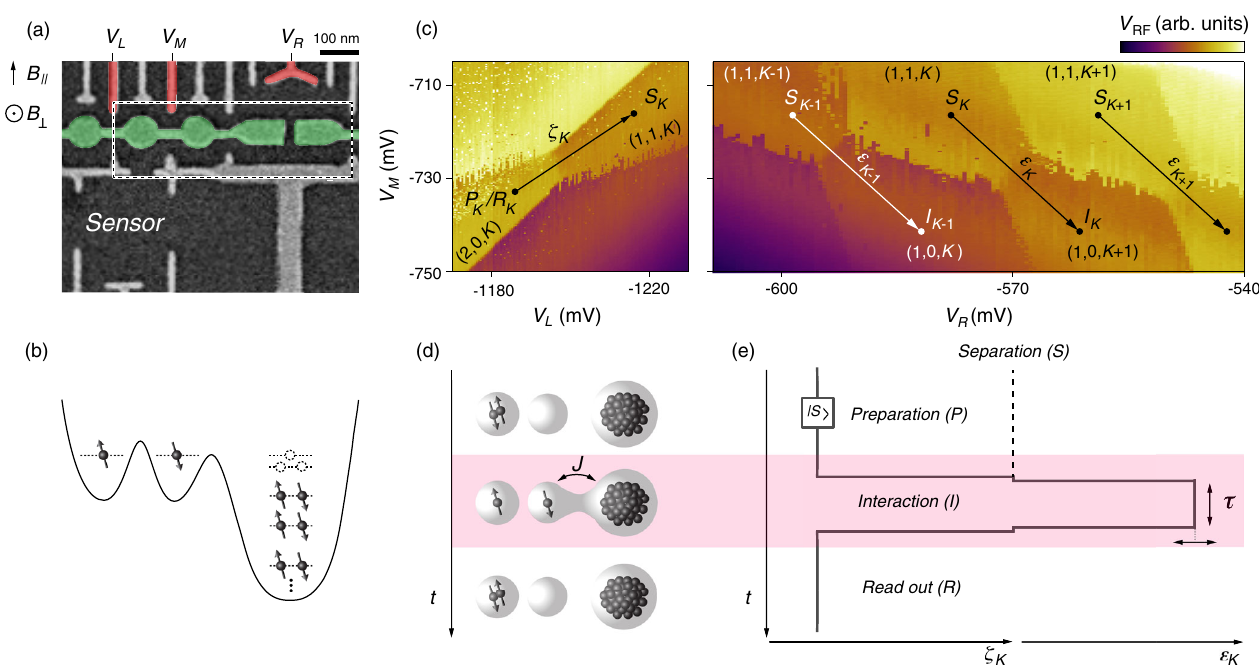
FIG. 1. (a) Scanning-electron micrograph of the device, colored in gray and red to indicate metallic gate electrodes that deplete the 2DEG below the surface (negative voltages). Accumulation gates (colored in green, positive voltages) steepen the resulting confining potential of the quantum dots that form underneath. Voltage pulses applied to the gates V control individual electrons in the triple- L;M;R dot array on a nanosecond time scale. (b) Illustration of the electron configuration in the resulting triple quantum dot. We refer to the left and middle dot as the double dot, and to the right dot as the multielectron dot. The precise single-particle level structure and occupation number of the right dot determine the spin properties of the multielectron dot, and are the focus of this experiment. (c) Charge diagrams of the triple quantum dot in the absence of voltage pulses. The left-hand panel shows the interdot charge transition of the two-electron double quantum dot. The right-hand panel presents the charge transition at which the middle electron transfers to the multielectron quantum dot, for different initial occupations of the multielectron dot ( K − 1 , K , and K þ 1 ) depending on V . Labels P , R , and S R K K K indicate positions in gate-voltage space at which the electron pair is, respectively, prepared, read out, and separated, if appropriate time- dependent voltage pulses are applied. In particular, arrows labeled ζ and ε indicate axes in gate-voltage space used to define the K K voltage pulses in this experiment. For example, gate voltages associated with the interaction step ( I ) are varied systematically (see K Sec. II), but always remain on the ζ or ε axis. (d) Operating principle of probing the multielectron spin state by the two-electron K K double dot. First, a pair of electrons is prepared in a singlet state on the left dot. Next, one of these electrons is transferred to the middle dot, allowing a spin-sensitive interaction ( J ) with the multielectron dot. In the last step, the spin of the middle electron is measured relative to the reference electron in the left dot by means of Pauli blockade. (e) Implementation of (d) by voltage pulses along ζ and ε . K K The outcome of each interaction cycle depends on pulse amplitude ( ε ) and duration ( τ ), and, crucially, on the occupation and spin of the multielectron